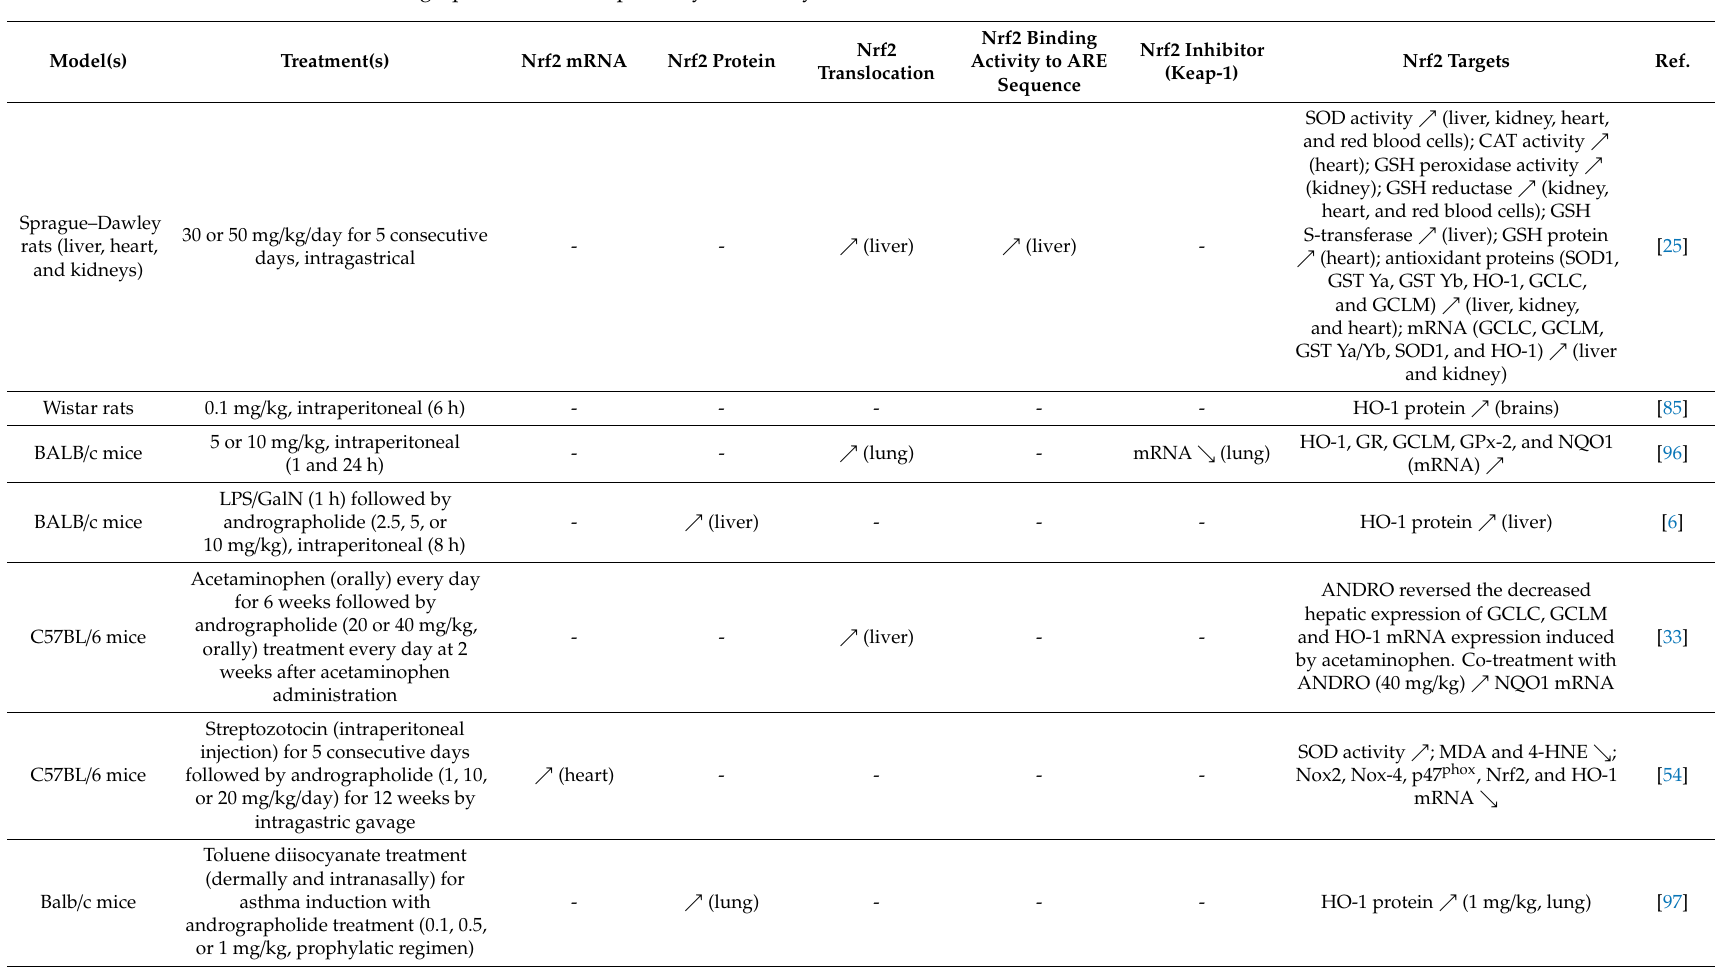
Table 2. Main e ff ects of andrographolide on Nrf2 pathway in vivo, Symbols: “ (cid:37) ” for an increase, “ (cid:38) ” for a decrease, and “-” for not